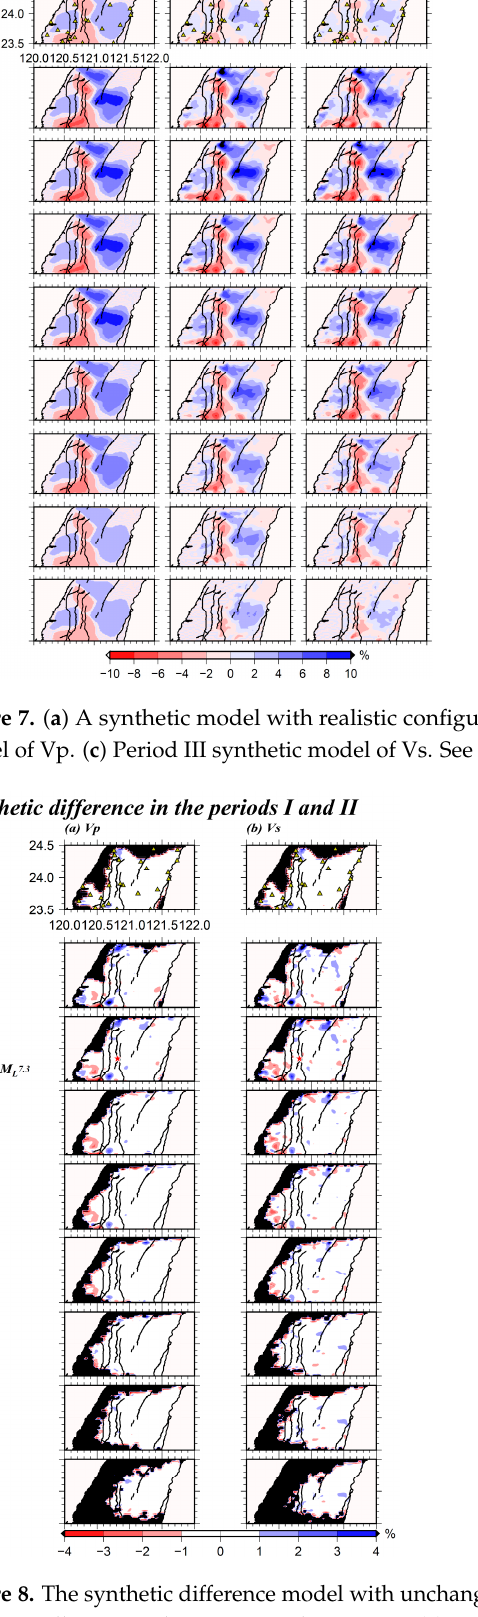
Figure 8. The synthetic difference model with unchanged synthetic model recovered using two data subsets. Yellow triangles represent the stations. ( a ) Synthetic difference of Vp in the periods I and II. ( b ) Synthetic difference of Vs in the periods I and II.